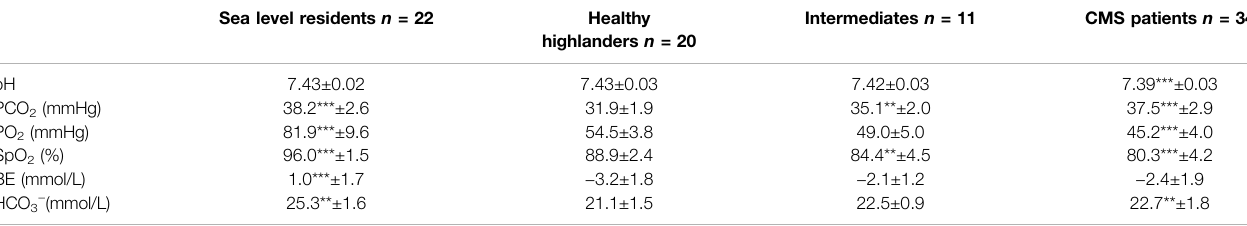
TABLE 2 | Blood gas and acid-base status.